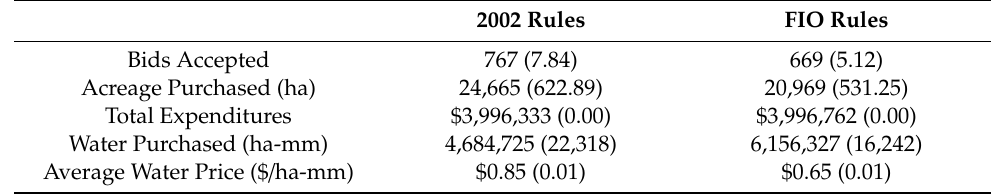
Table 4. Simulation results with auction budget constrained to $4